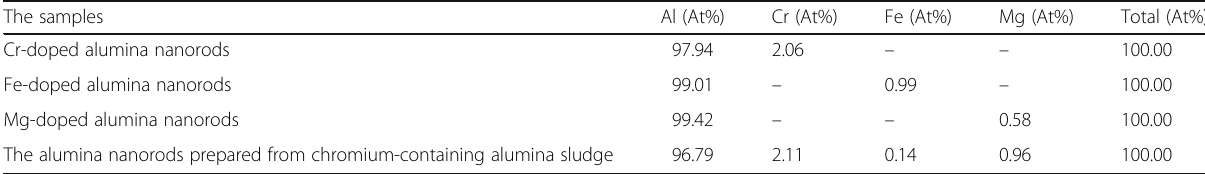
Table 3 The EDS results of aluminum nanorods precursors doped with different ions The